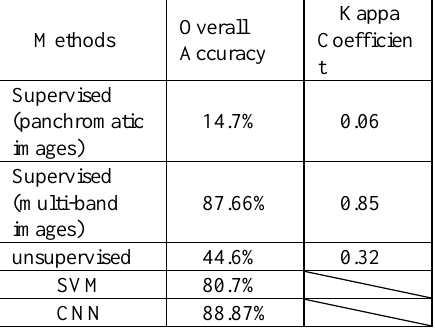
Table 4. Different Classification